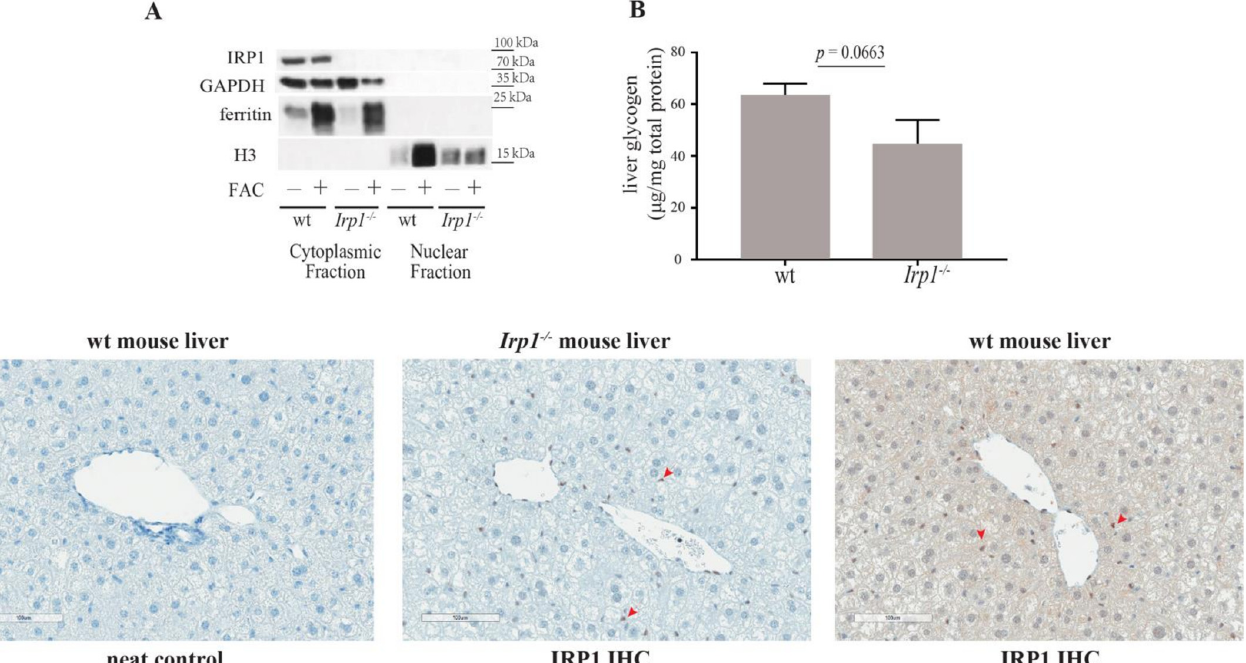
Figure 2. Subcellular IRP1 localization in primary murine hepatocytes and liver sections, and assessment of potential impact of IRP1 ablation in liver glycogen content. ( A ) Western blot analysis of IRP1, GAPDH, ferritin and H3 in whole cell lysates, cytoplasmic supernatants and nuclear extracts from primary wild type (wt) and Irp1 − / − hepatocytes, either previously treated with 100 µ g/mL FAC for 18 h, or not. ( B ) Glycogen content in the liver of 16-week-old male wild type ( n = 8) and Irp1 − / − ( n = 4) mice. Statistical significance was evaluated by using the unpaired Student’s t test. ( C ) Immunohistochemistry (IHC) of IRP1 in the liver of wild type and Irp1 − / − mice. Red arrowheads indicate non-specific